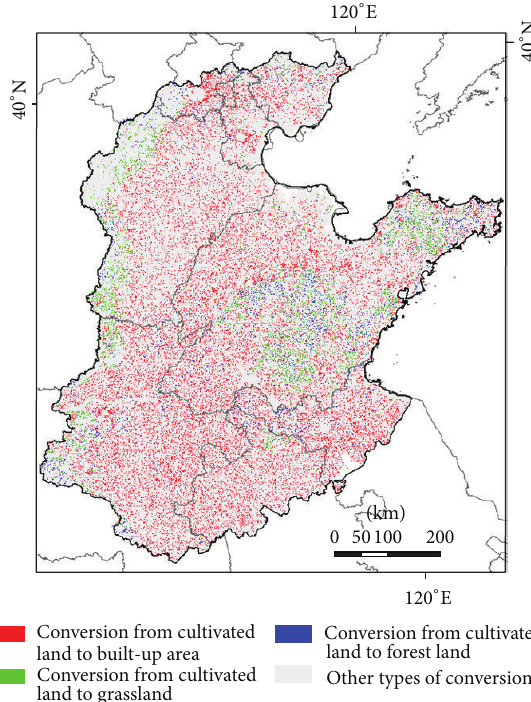
Figure 7: Land conversion from cultivated land to three major land use types during 2000–2008.